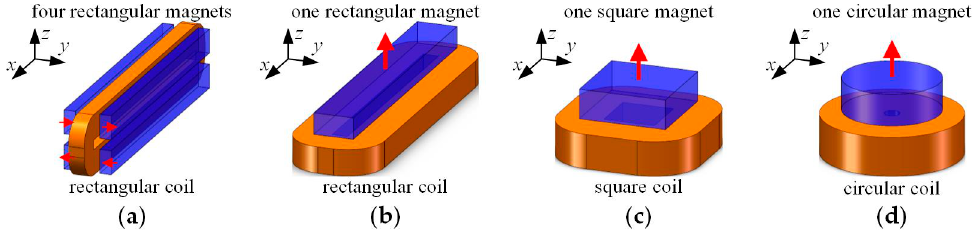
Figure 3b, w m 2 = 9.5 mm, t m 2 = 5.12 mm, w c 2 = 8.9 mm, t c 2 = 6.3 mm, w s 3 = 3.7 mm, t s 2 = 1 mm, = 18 mm, t m = 8 mm, w c = 6 mm, t c = 5 mm, w s = 2 mm, t s = 2 mm, y q = 8 mm, z q = 8 mm, model depth 36.86 mm. The stroke is set to be ±0.5 mm × ±0.5 mm.